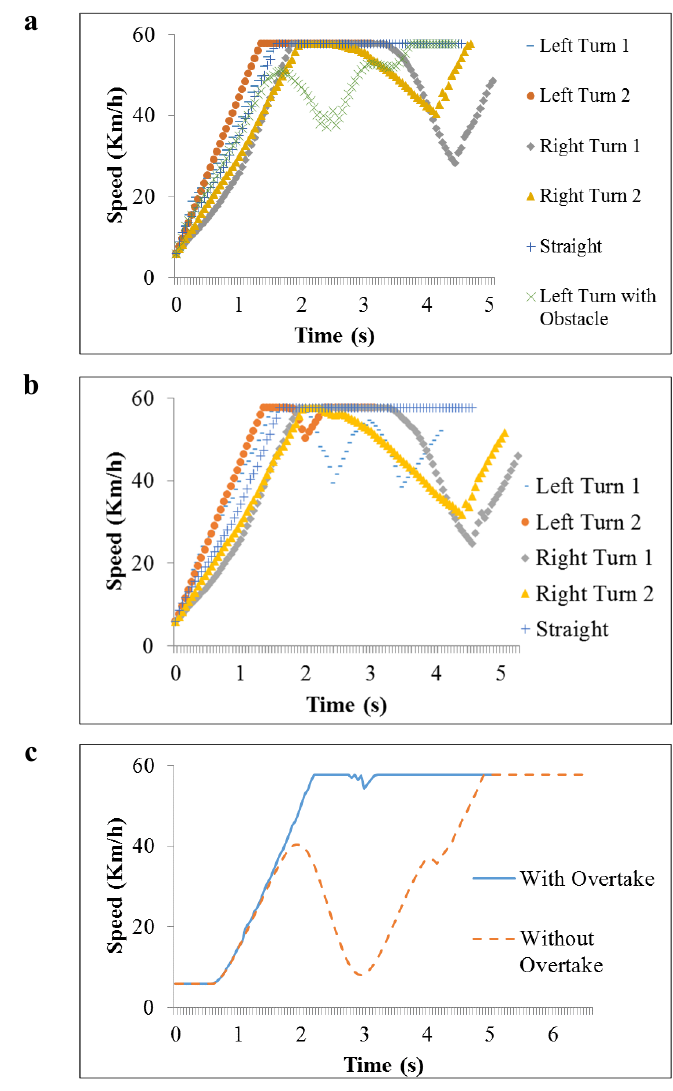
Figure 14. Relation between speed and time for: ( a ) scenarios with one vehicle; ( b ) scenarios with two vehicles; ( c ) overtaking